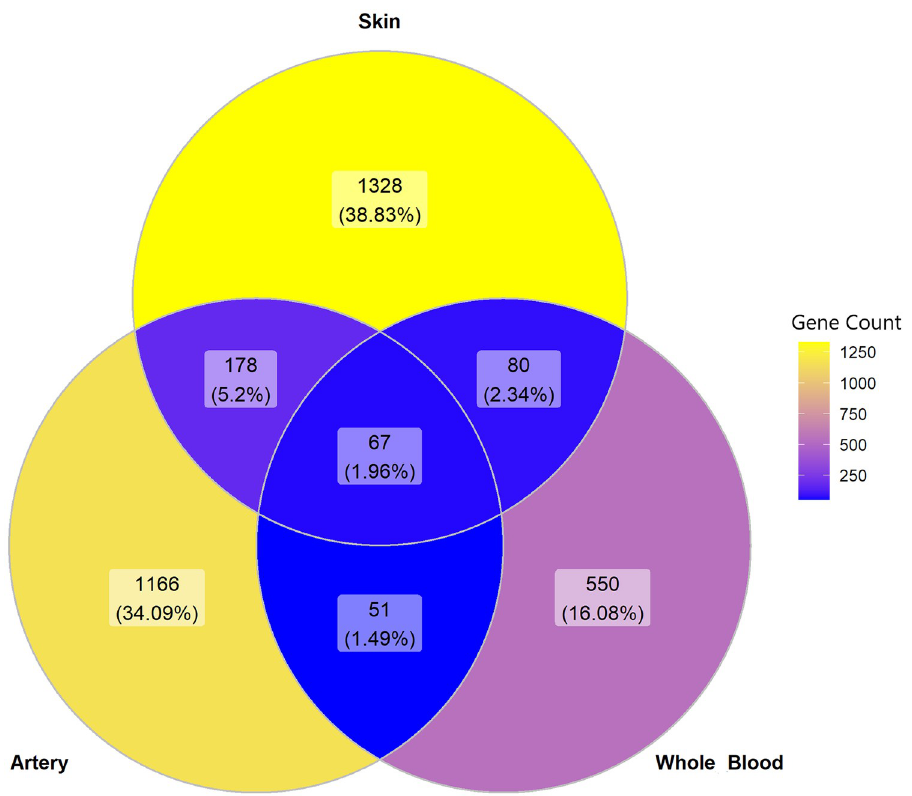
Fig 4. Venn diagram of DEGs across tissues. Overlapping regions represent DEGs shared between comparisons. The color scale is proportional to the number of DEGs.